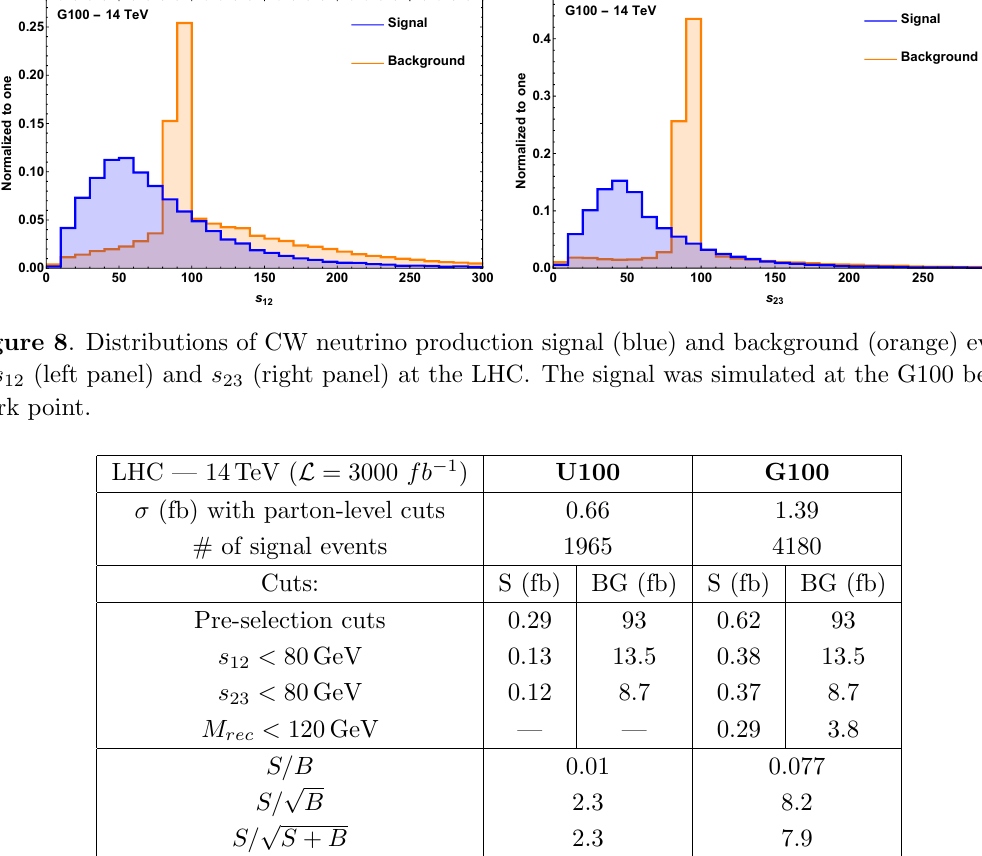
Table 4 . Cut (cid:13)ow for the search for CW neutrino production in the 3 ‘ + E= T channel at the HL-LHC ( = 3 ab (cid:0) 1 L